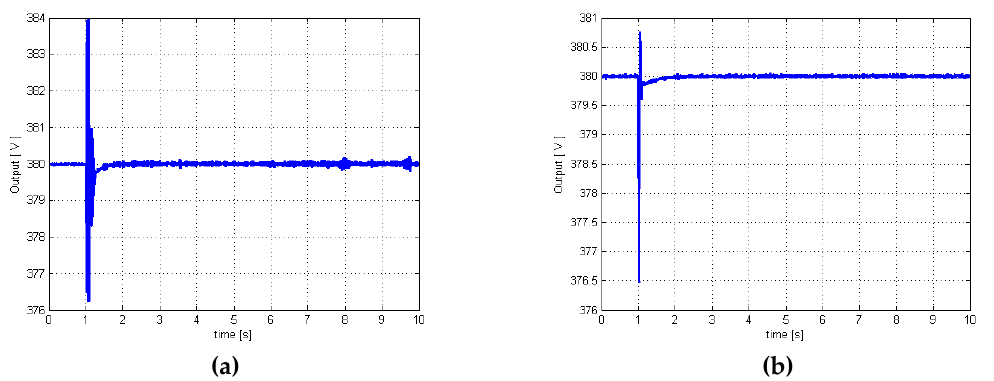
Figure 10. ( a ) Controlled output—minimum variance controller (( ρ = 0.1, ∆ T m = 10%), small Figure 10. (a) Controlled output—minimum variance controller (( (cid:2025) = 0.1, (cid:1986)(cid:1846) (cid:3040) = 10%) , small disturbance); ( b ) Controlled output—classical PID controller (( ∆ T m = 10%), small disturbance); ( b) Controlled output—classical PID controller (( (cid:1986)(cid:1846) (cid:3040) = 10% ) , small disturbance)